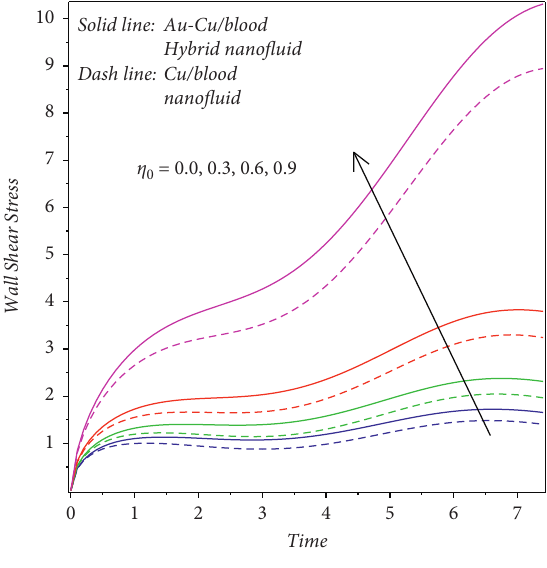
Figure 18: Behaviour of M